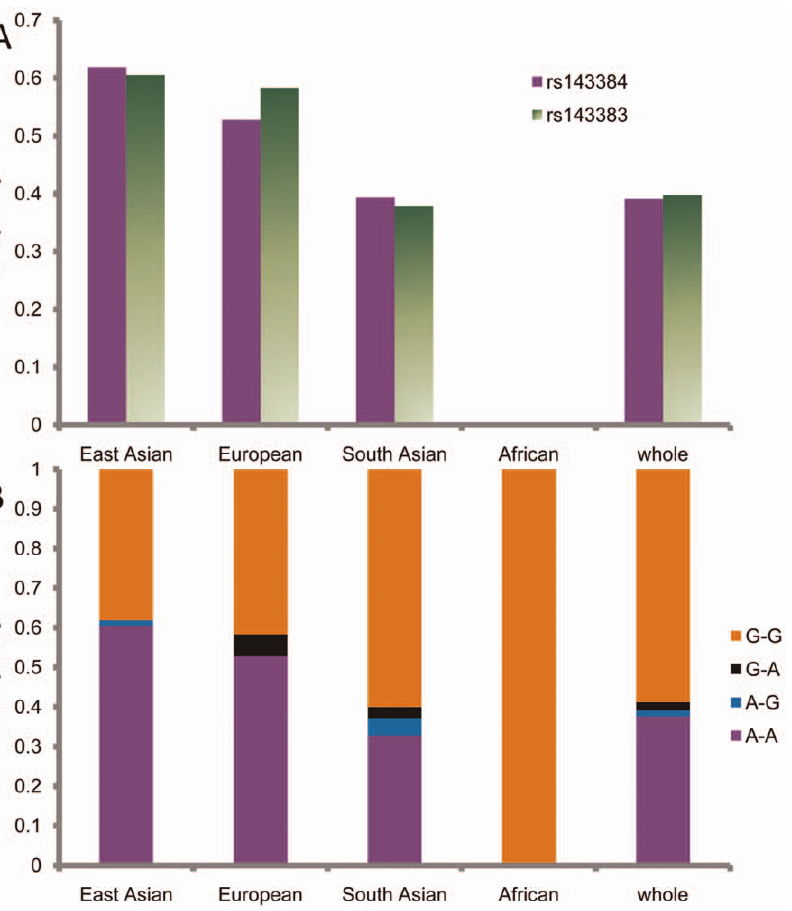
Figure 2. SNP allele frequencies in the GDF5 gene. (A) Allele frequencies of haplotypes constructed using SNP rs143384 and rs143383 in four separate populations and the whole population. (B) Derived allele frequencies of the two SNPs in the four populations and the whole